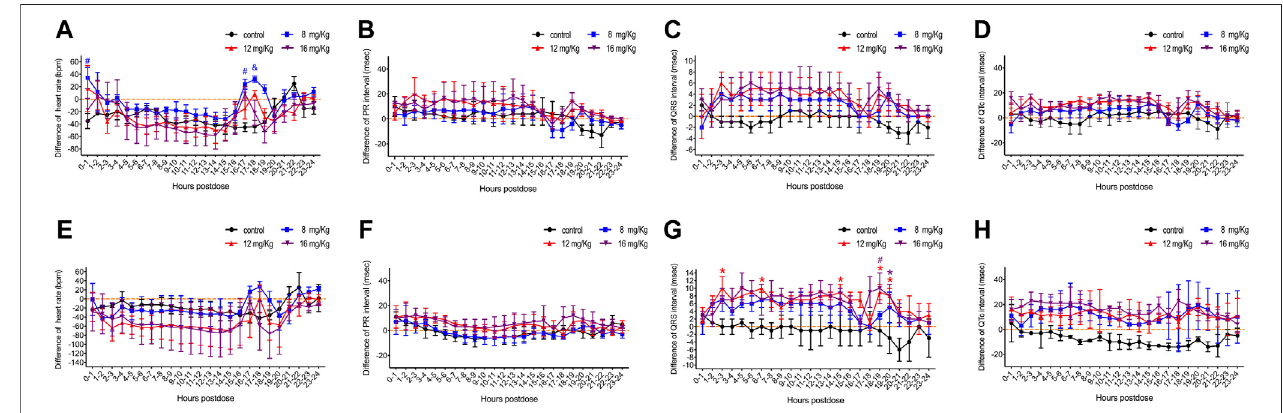
FIGURE 3 | The difference value of heart rate, QRS interval, PR interval and QT interval in male (A – C) and female (D – F) rats. The difference value was calculated from the measured value minus the mean value for the two hours before drug administration. Data were depicted asthe mean ± SD. Compared with control group, * p < 0.05; # p ≤ 0.01; & p ≤ 0.001.